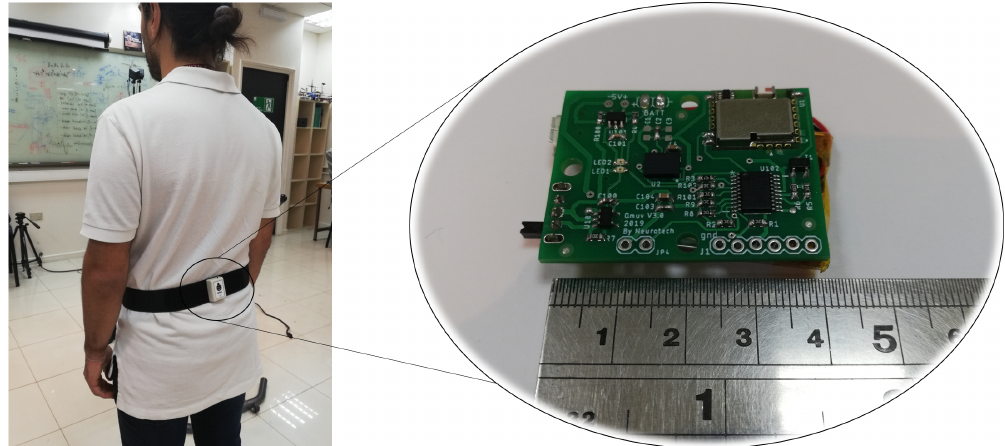
Figure 2. IMU sensor develop in the biomedical engineering laboratory of the Universidad de Concepción,